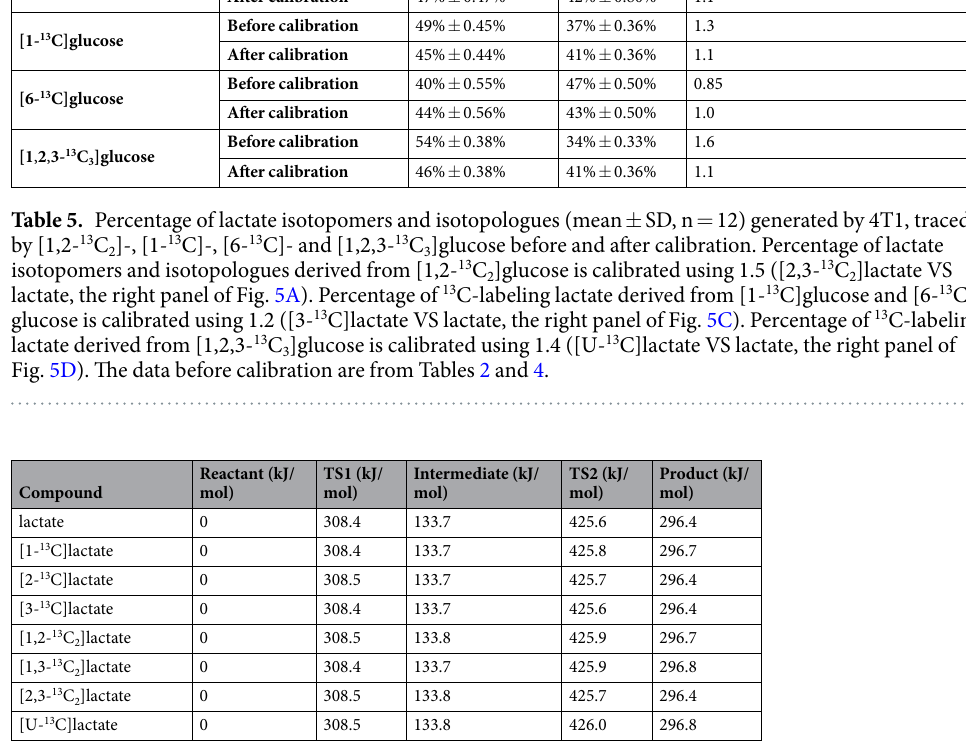
Table 6. Relative energies of species involved in the fragmentation reaction routes of lactate isotopomers and